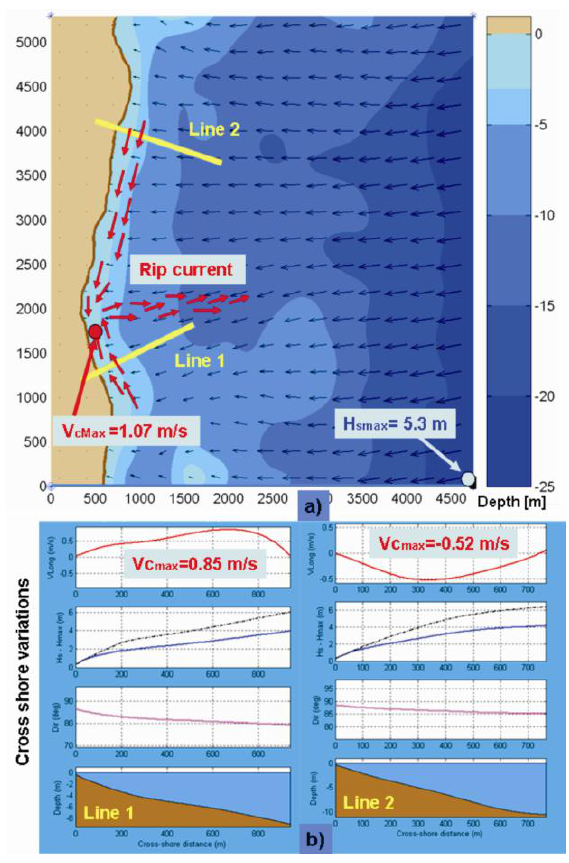
Fig. 3. Estimation of the nearshore currents driving the pollu- tion along the coast (time frame 2002/03/13/h00): a) 2D repre- sentation of the wave conditions and of the wave induced currents in the nearshore (resulting from SWAN and SHORECIRC simulations); b) Cross shore variations of the longshore currents (resulting from ISSM